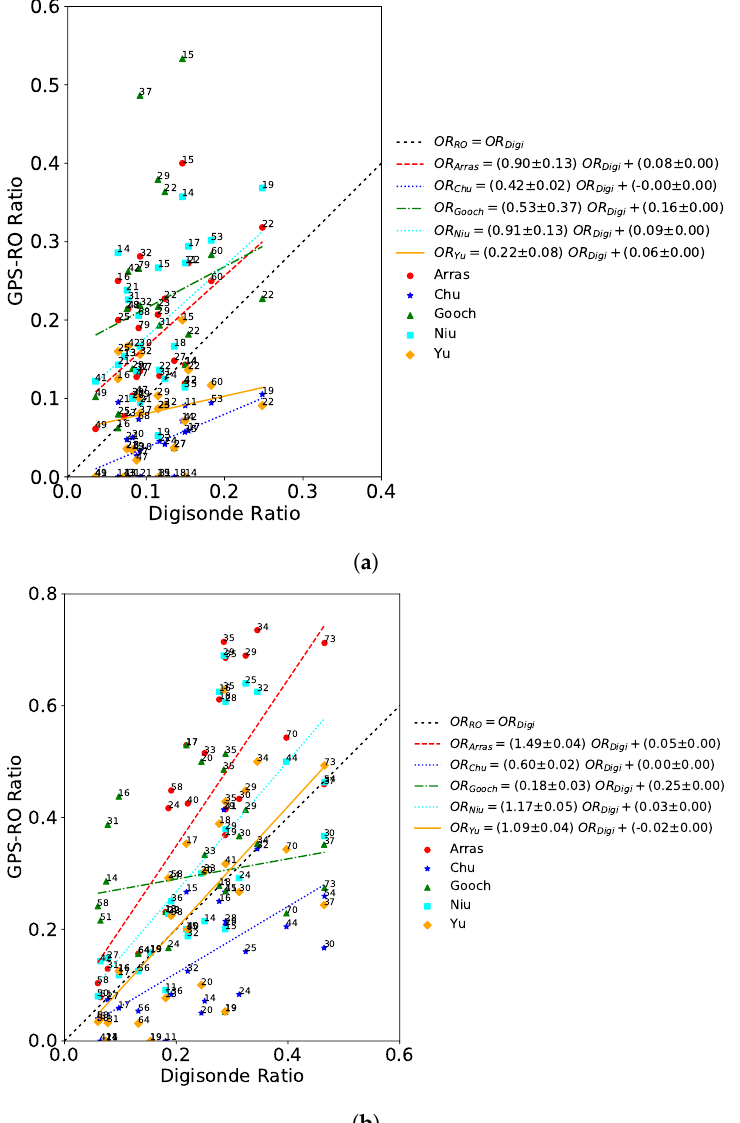
Figure 2. Sporadic-E total occurrence rates for each GPS-RO technique separated by Digisonde site with no lower limit on E s intensity. Linear regressions and corresponding variances calculated using a bootstrapping technique with 10,000 samples are also displayed. The annotated numbers near each data point correspond to the number of GPS-RO observations for the season within 170 km of the Digisonde site used for comparison. The black dashed one-to-one line indicates a perfect match between data sets. Note the change in scale between the two figures and the variable number of Digisonde sites with sufficient GPS-RO crossings during the different seasons (22 sites for December– February and 25 for June–August). ( a ) December, January, and February 2010–2017. ( b ) June, July, and August